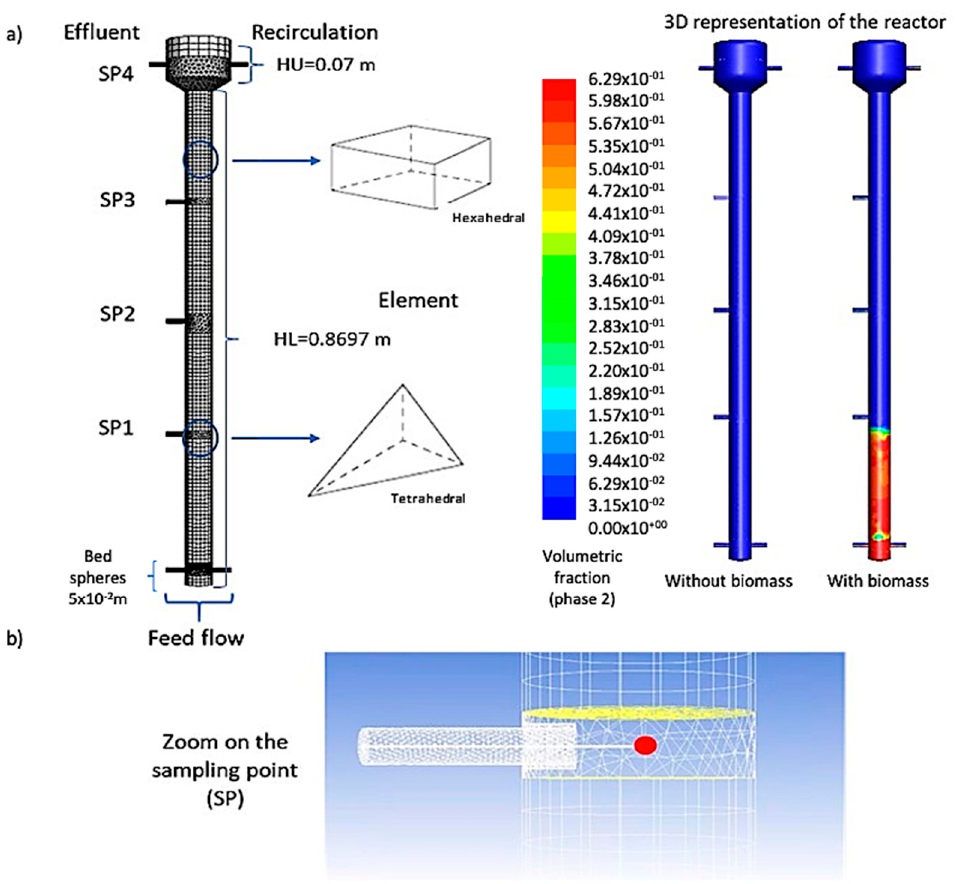
Figure 1. ( a ) Computational fluid meshing and sampling (monitoring point). SP1, SP2 and SP3 are the sampling ports along the reactor height (at 0.26, 0.46, and 0.67 m, respectively), while SP4 is the effluent port (at 0.92 m height). The recirculation port is placed opposite to SP4. SP = sampling point; ( b ) Zoom on the sampling point.